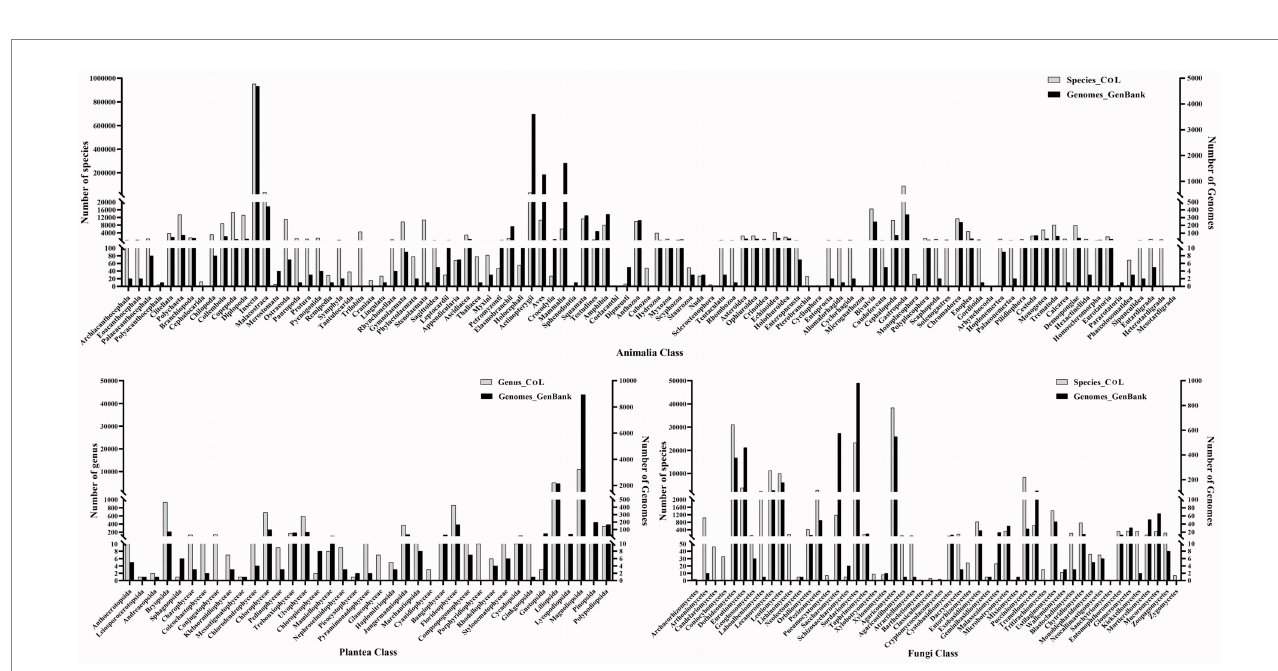
FIGURE 2 Statistics of species/genus number and whole genomes at class level in Animalia, Plantae and